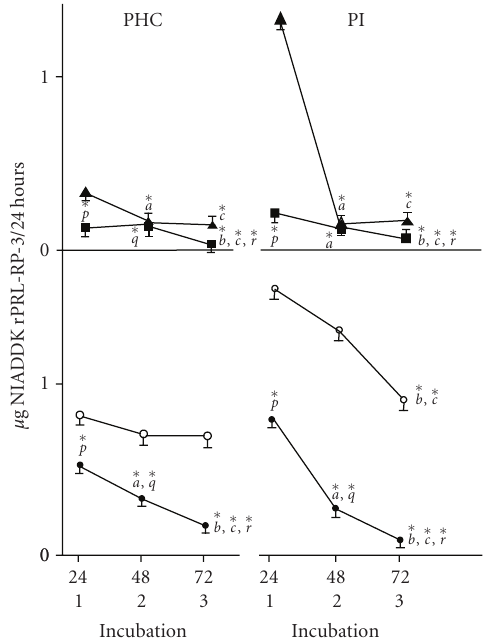
Figure 3: Release of PRL by PHC and PI of normal and castrated rats incubated with or without testosterone for 72 hours. Upper panel. Pattern of release of PRL by PHC and PI of castrated rats, incubated in absence ( (cid:2) ) or presence ( (cid:3) ) of testosterone (0.3mM) for 72 hours. Values are mean ± SE and derived from 40 individual incubations of PHC and 16 of PI, respectively. Lower panel. Pattern of release of PRL by PHC and PI of normal rats incubated in absence ( ◦ ) or presence ( • ) of testosterone (0.3 mM) for 72 hours. Values are mean ± SE and derived from 15 individual incubations of PHC and 16 PI, respectively. a , b , c denote significant di ff erence in values at 48 hours as compared to 24 hours, at 72 hours as compared to 48 hours, and at 72 hours as compared to 24 hours, respectively. p , q , r denote significant di ff erence in groups incubated with or without testosterone at 24, 48, and 72 hours, respectively. ∗ P ≤ . 05. Pituitary constructs were dissected out of normal or 7-day castrated rats and incubated in DMEM with or without 0.3mM testosterone, at 37 ◦ C for 24–72 hrs. Prolactin was analysed in the spent medium by RIA